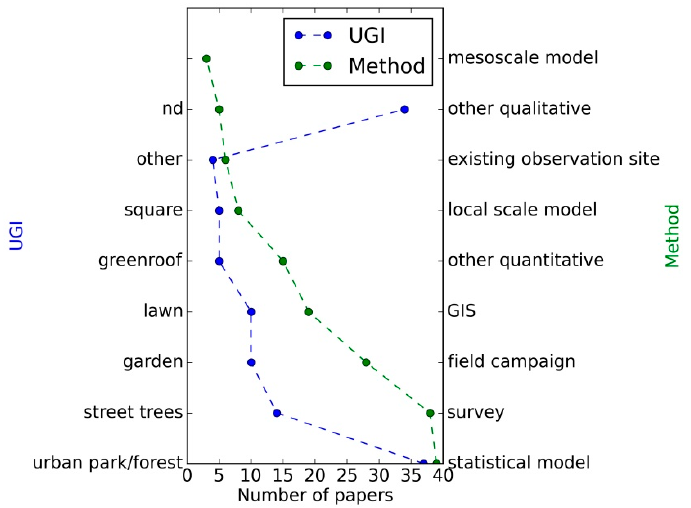
Figure 4. Distribution of number of articles by Urban Green Infrastructure (UGI) type and research method. “nd” stands for unspecified or undetermined (e.g., green spaces).